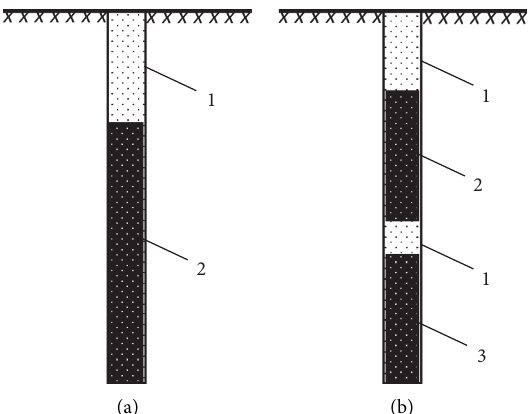
Figure 1: Charge structure of one-step blasting and two-step blasting (1- stemming; 2- explosive detonated by 1#detonator; 3- explosive detonated by 2#detonator). (a) One-step blasting. (b) Two-step blasting.